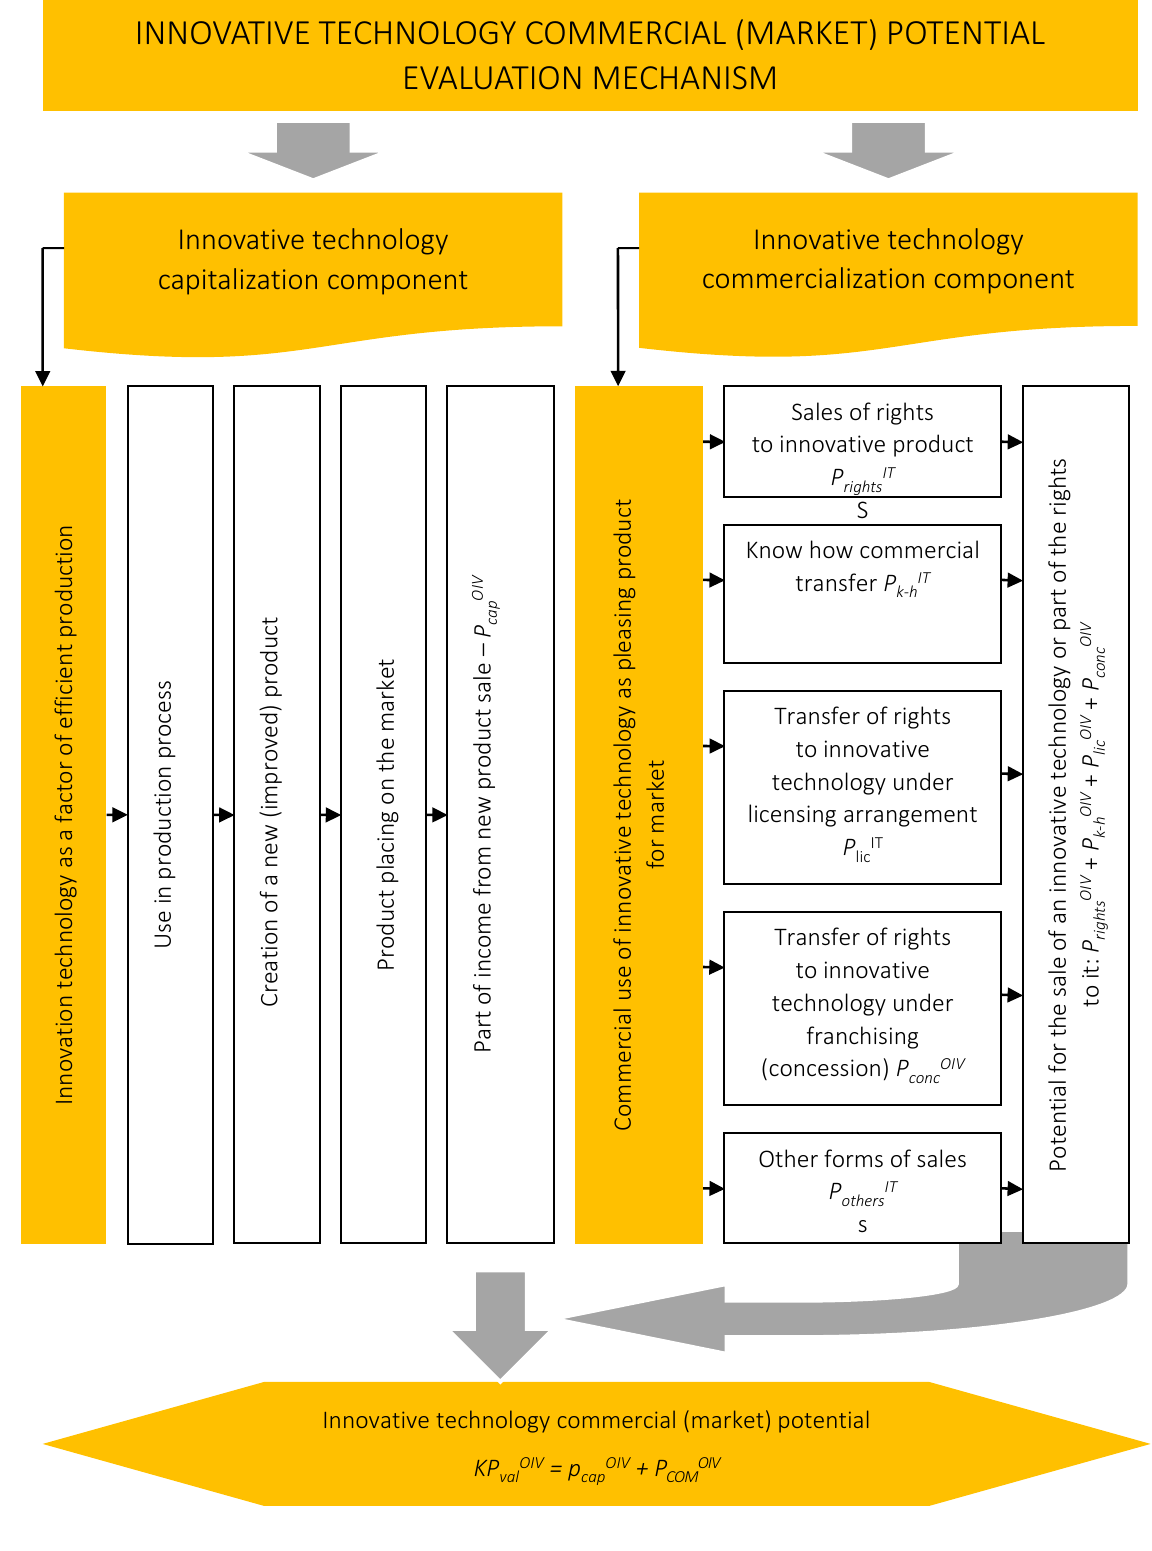
Figure 1. Practical realization mechanism of innovative technology market